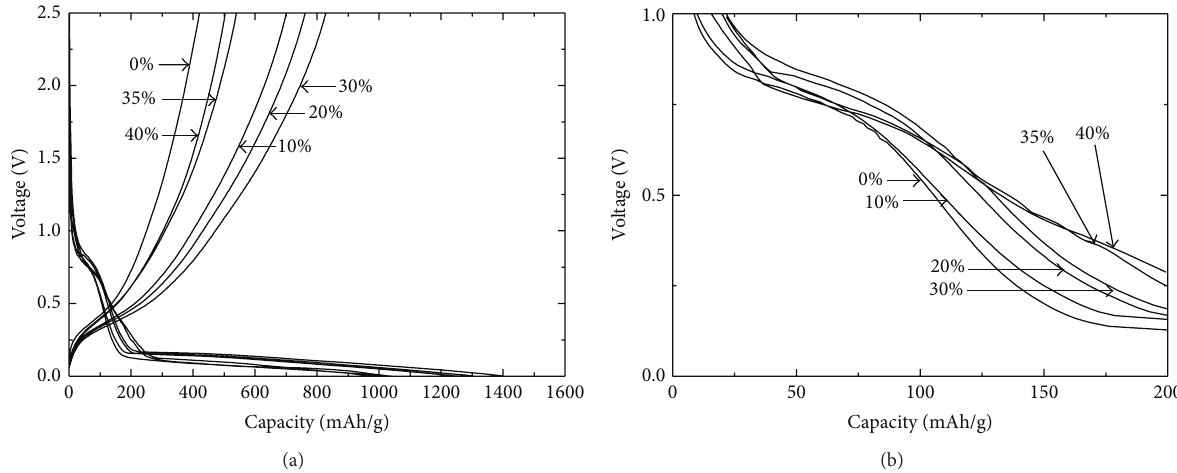
Figure 3: I - V characteristics during the first cycle of electrochemical charging/discharging (a) for SiO 𝑥 anode samples with different amounts of pitch carbon (0wt% to 40wt%) at a fixed amount of 10wt% of conductive carbon blacks, where (b) is a magnification for the range of 0 V to 1.0 V in